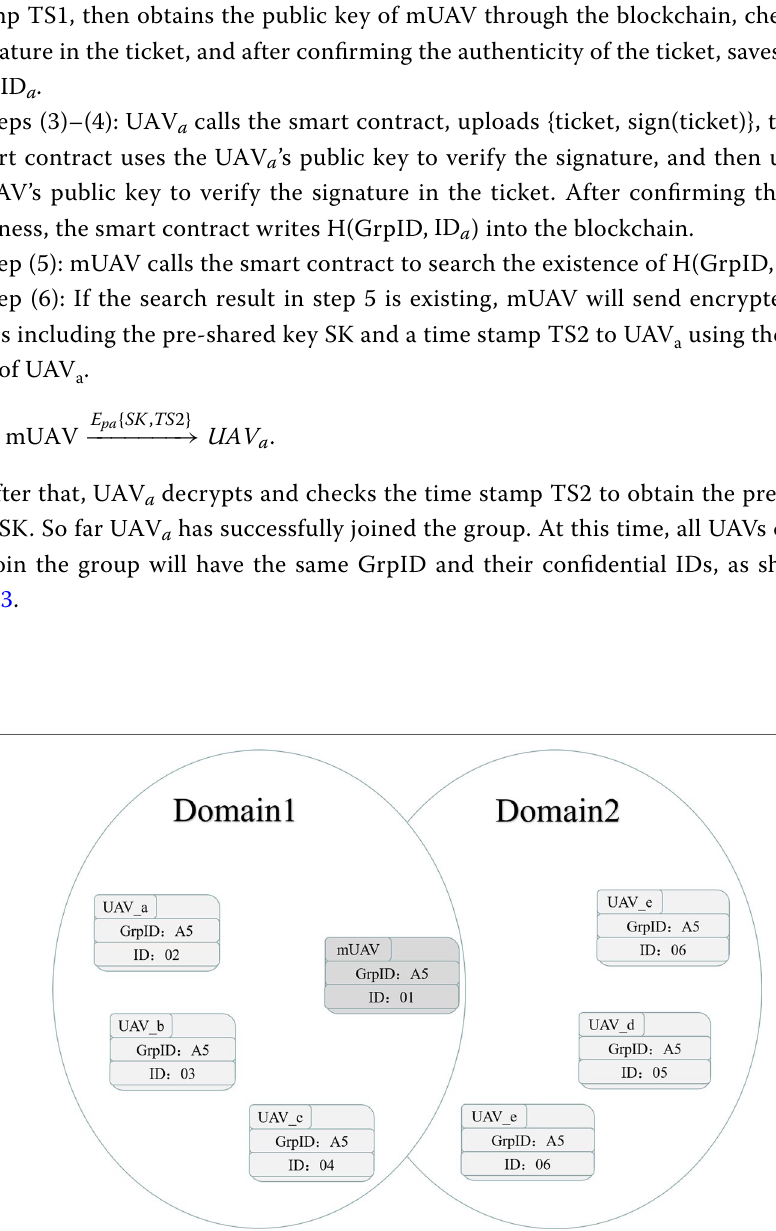
Fig. 3 An instance of a group containing UAVs from two domains. This figure shows how UAVs in different domains build